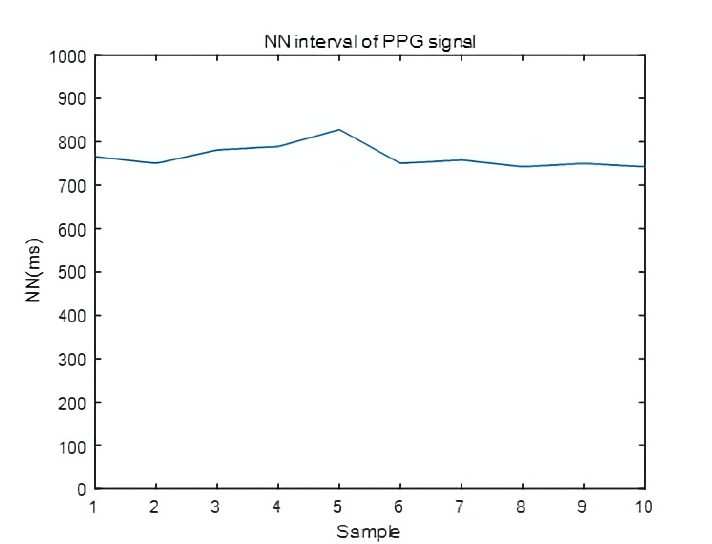
Figure 5. NN interval of the PPG